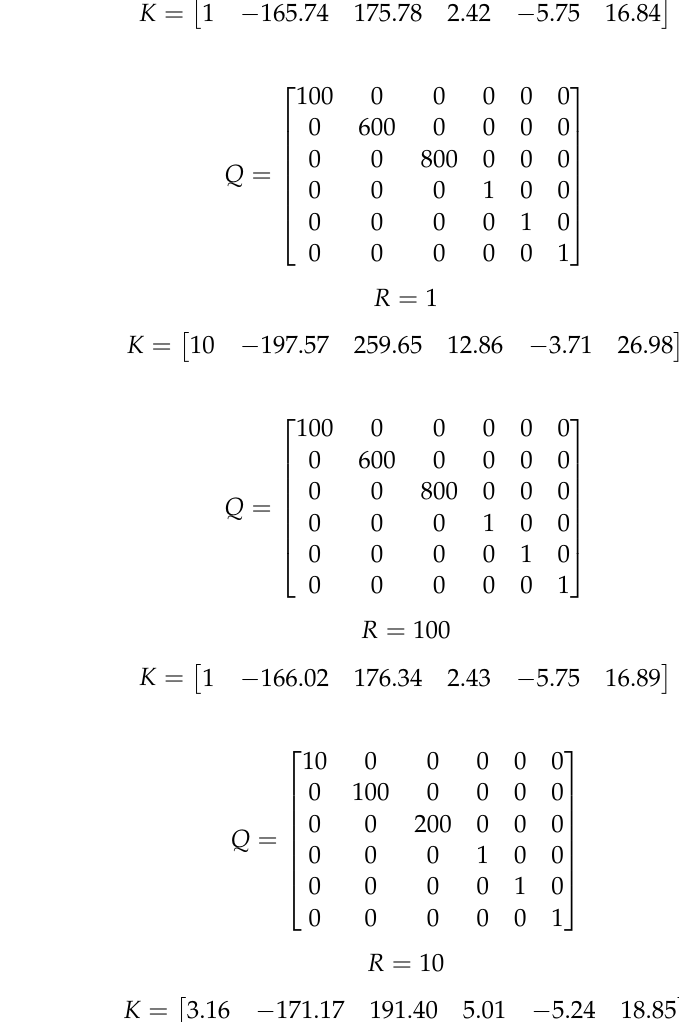
Figure 7 Results of the step response of the first three variables in all cases.